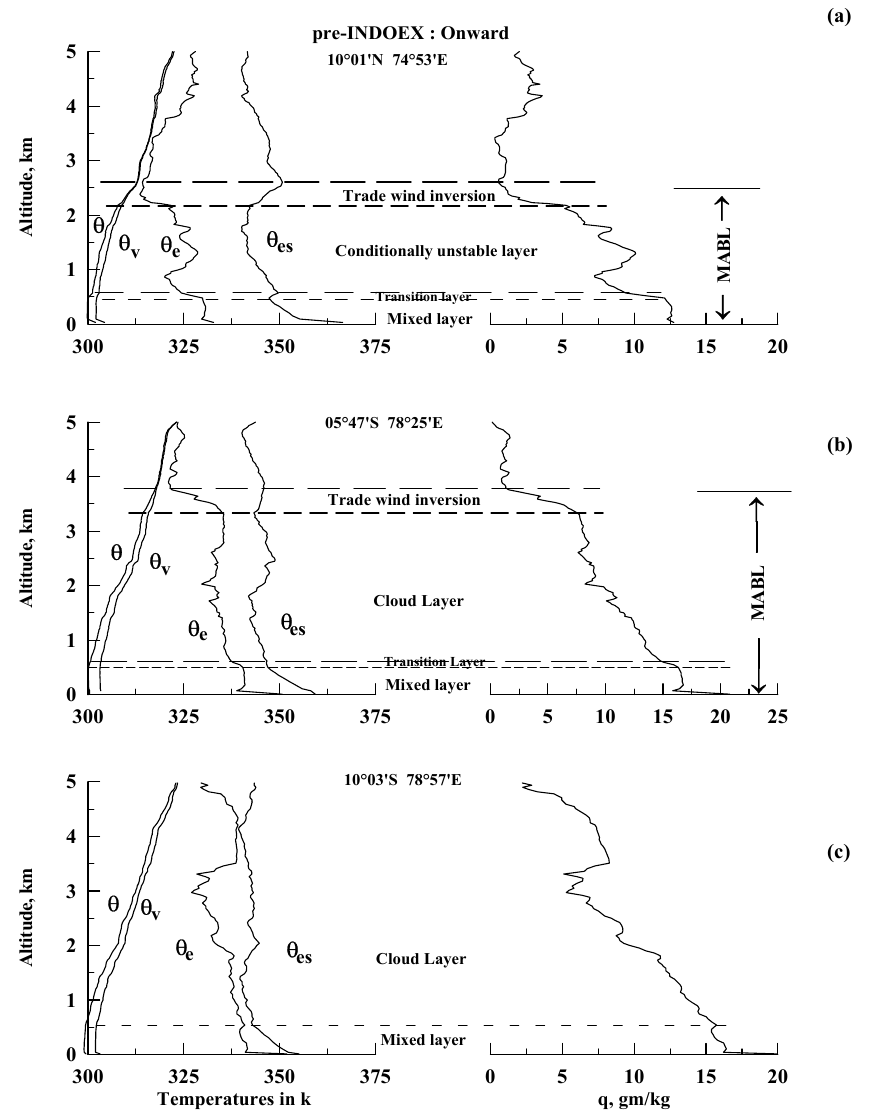
Fig. 2. Altitude profiles of potential temperature ( θ ), virtual potential temperature ( θ v ), equivalent potential temperature ( θ e ), saturated equivalent potential temperature ( θ es ) and mixing ratio ( q ) during the on ward track of